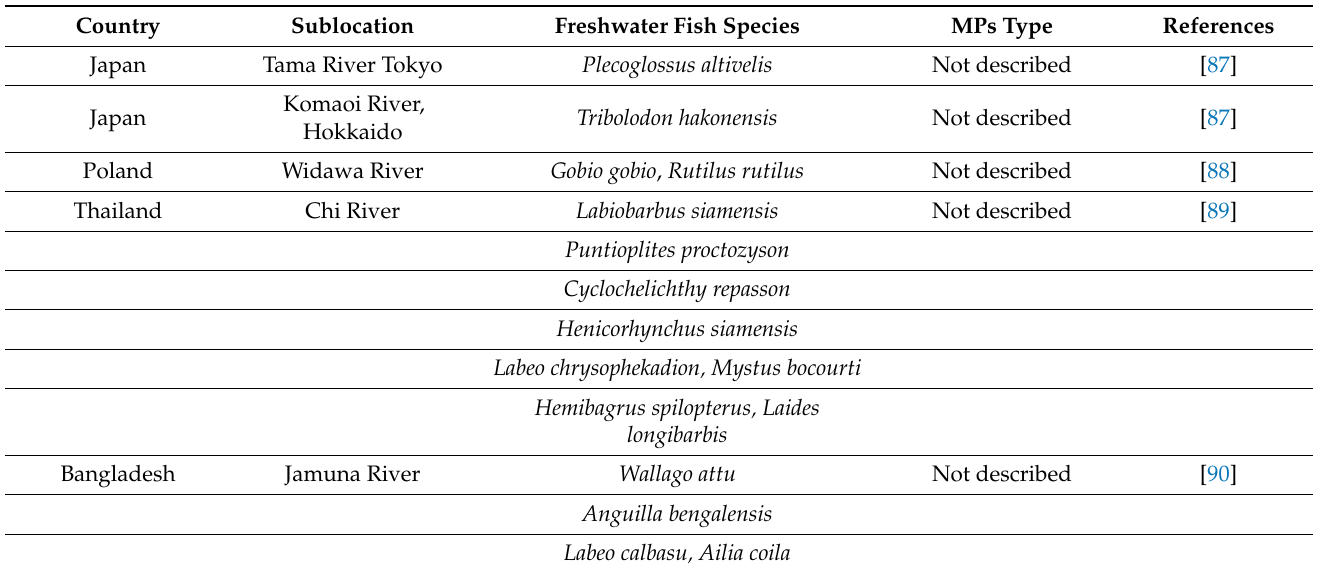
Table 1. Overview of distribution over the world of freshwater fishes subjected to MPs’